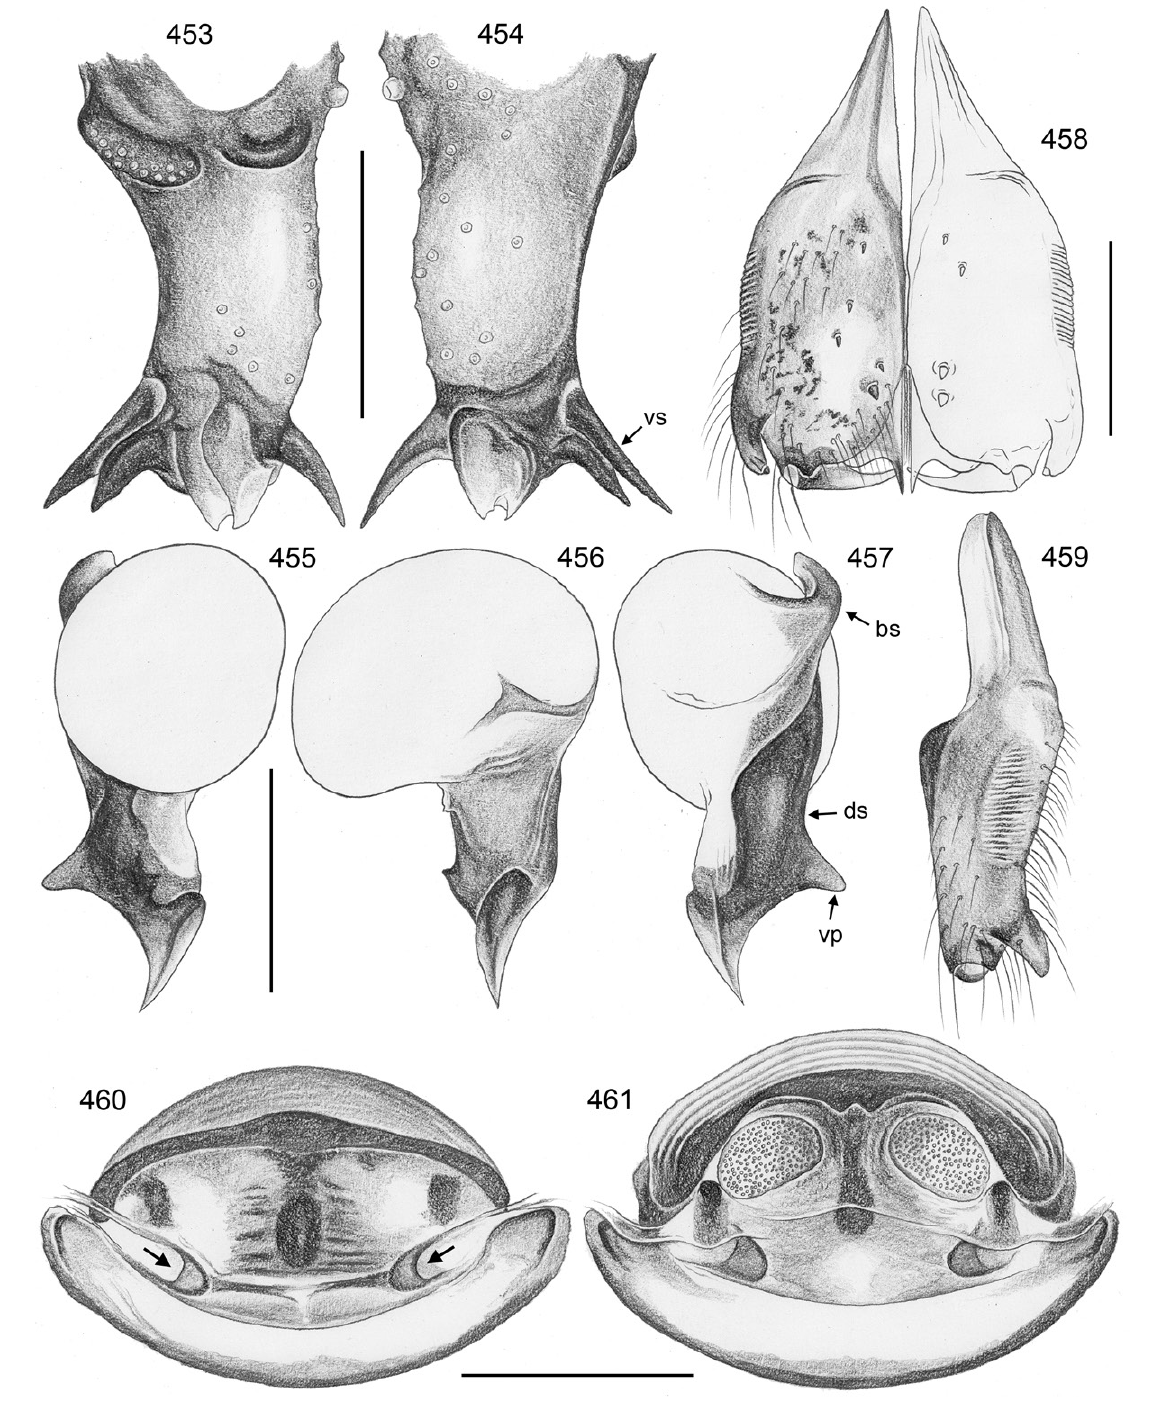
Figs 453–461. Crossopriza dhofar sp. nov.; male from Oman, Ain Razad cave (ZFMK Ar 22412), female from Oman, Wadi Nahiz (ZFMK Ar 22413). 453–454 . Left procursus, prolateral and retrolateral views. 455–457 . Left genital bulb, prolateral, dorsal, and retrolateral views. 458–459 . Male chelicerae, frontal and lateral views. 460–461 . Cleared female genitalia, ventral and dorsal views; arrows: pockets. Abbreviations: bs = basal sclerite; ds = distal sclerite; vp = ventral process (of distal sclerite); vs = ventral sclerite. Scale bars = 0.3